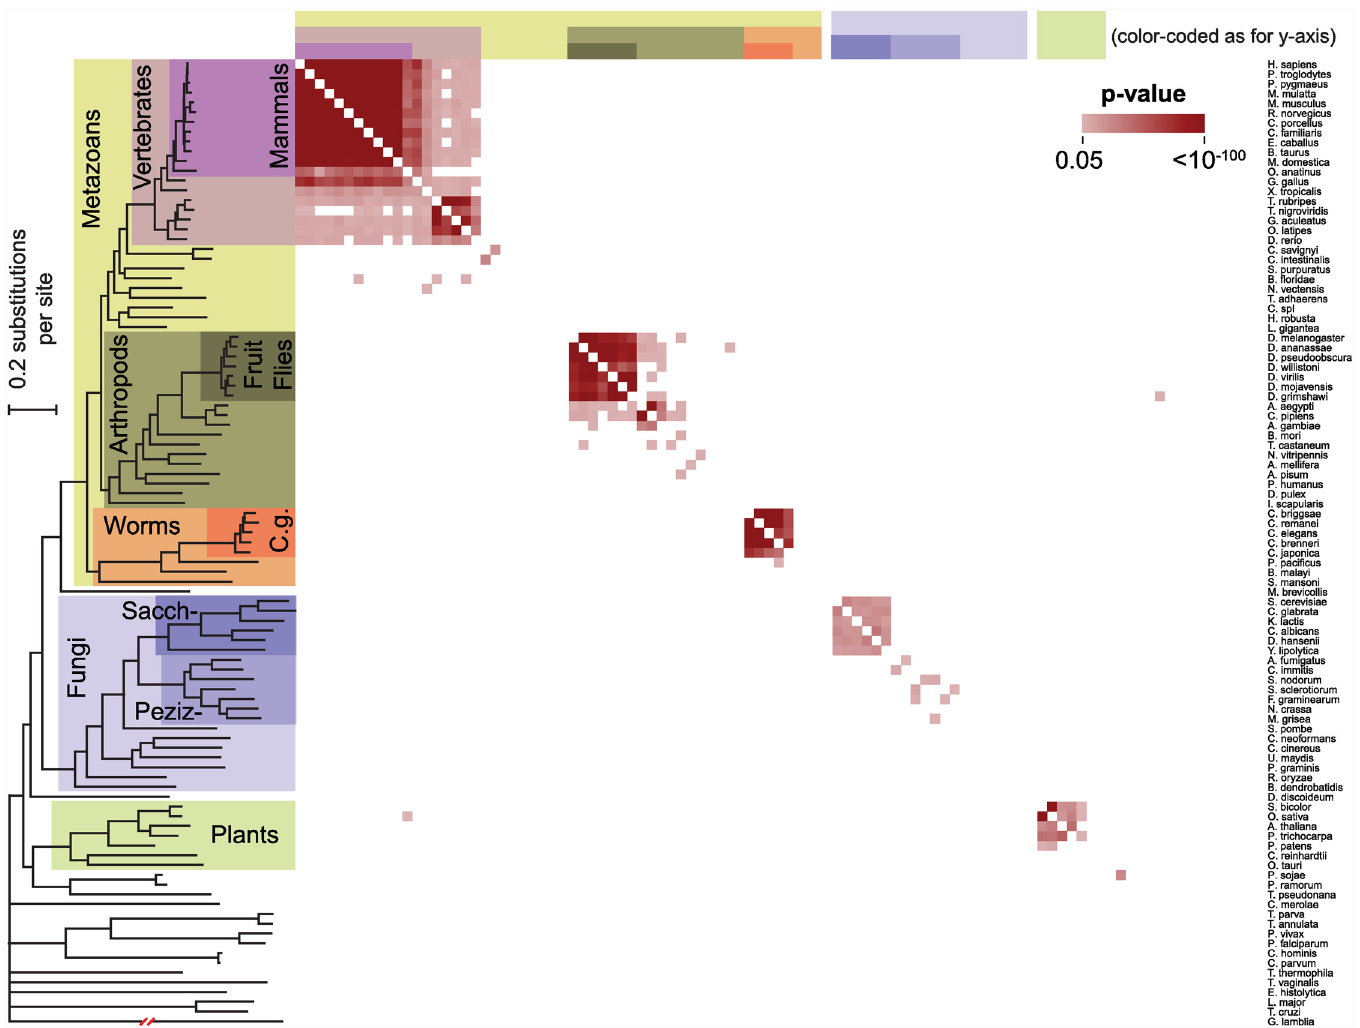
Fig 2. Conservation of Puf3 RNA targets across eukaryotes. A heatmap displaying whether the Puf3 binding sequence UGUA[ACU]AUA is shared by orthologs in a pair of species. A significant p -value is displayed as a colored square and was determined by the hypergeometric test. Color is used only if the Puf3 motif ranks in the top 1% relative to all motif permutations (Materials and Methods). (The heatmap is not fully symmetrical since the orthology assignments are not necessarily reciprocal.) The phylogeny shown was inferred using a maximum-likelihood approach from a concatenated alignment of 53 protein sequences (Materials and Methods). "Sacch-" refers to Saccharomycotina fungi, "Peziz-" to Pezizomycotina fungi, and "C.g." to the Caenorhabditis genus of worms. The break noted in red corresponds to 0.5 substitutions per site in the branch to Giardia lamblia . p -Values and ranks of the Puf3 motif against its permutations can be found in S9